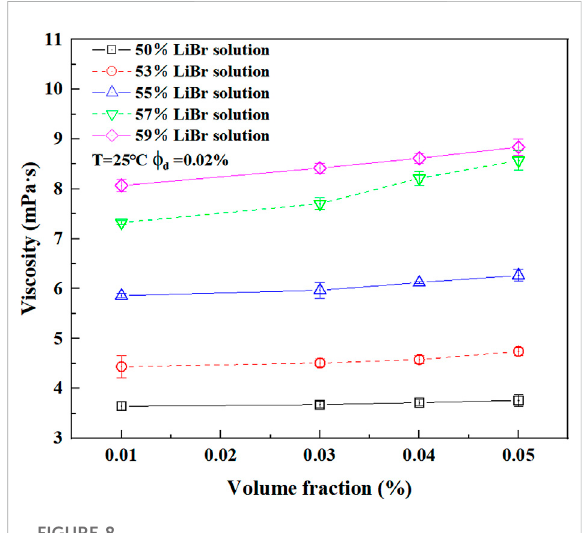
FIGURE 8 The variation of the viscosity of different concentration LiBr which added E414 in the volume fraction of 2% with the nanoparticles volume